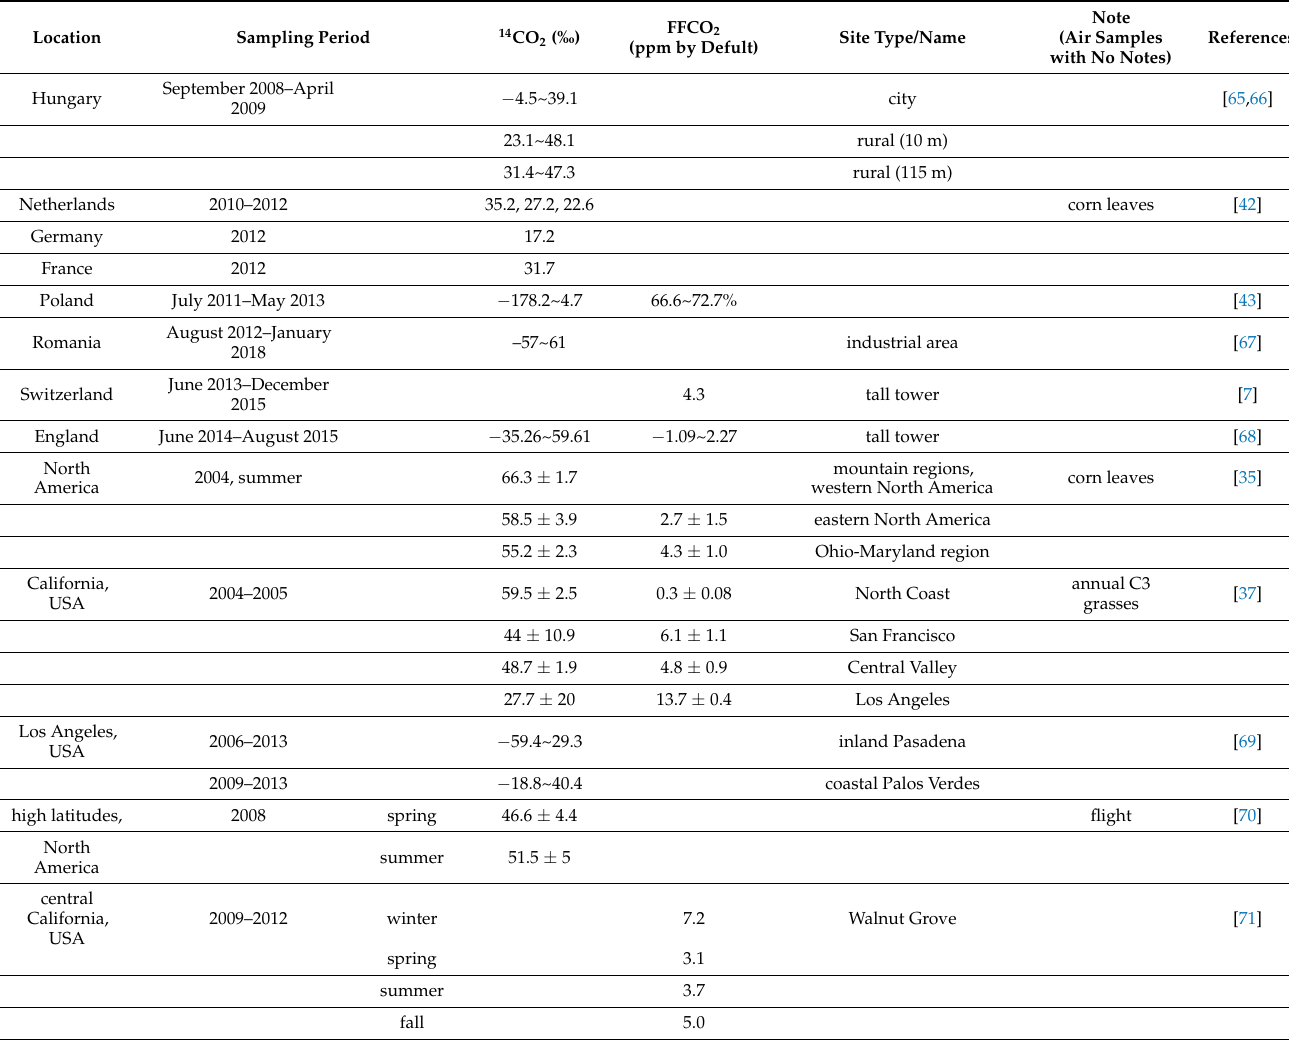
Table 1. ∆ 14 CO 2 measurements and calculated FFCO 2 concentrations reported in the last two